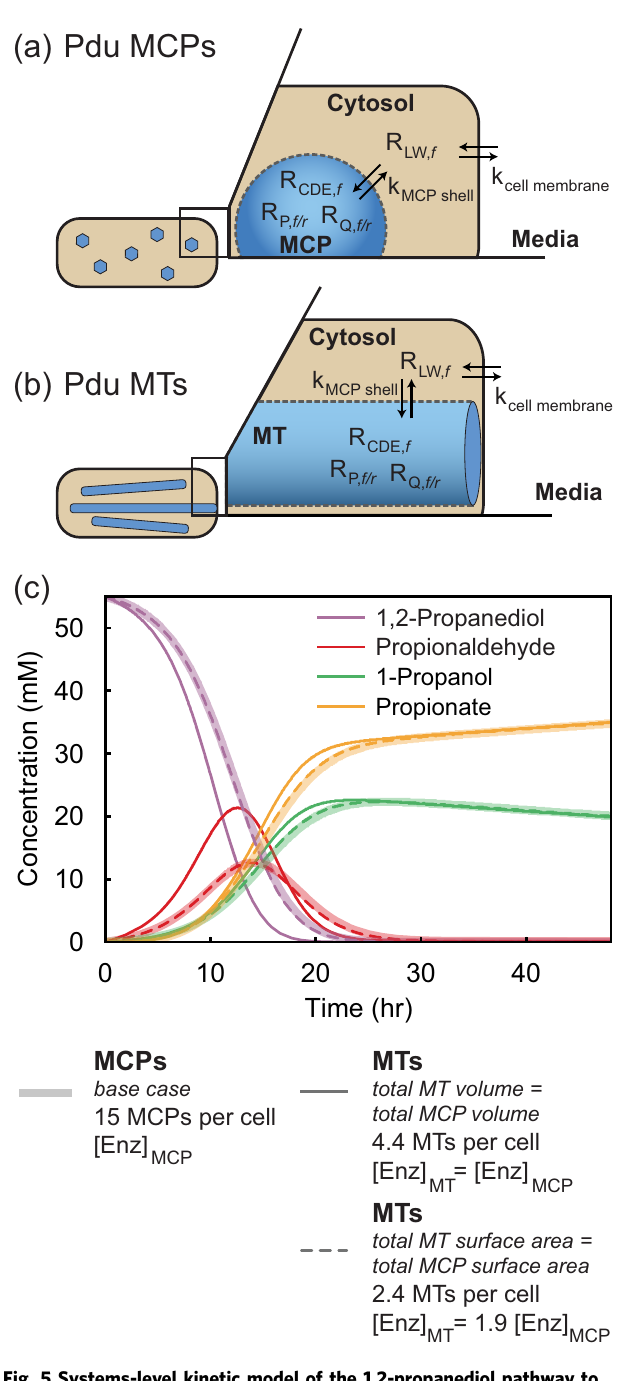
Fig. 5 Systems-level kinetic model of the 1,2-propanediol pathway to explore the impact of compartment geometry on pathway performance. a Spherical MCP model, where R refers to a reaction by a given enzyme, and k refers to diffusion across a barrier (the compartment shell or cell membrane) with a given permeability. b Cylindrical Pdu MT model. c Representative metabolite pro fi les in external media produced by the model for the spherical MCP base case (thick, slightly transparent lines), and limiting cylindrical MT cases (thinner, darker lines--solid for the case where internal MT volume is assumed the same as total MCP volume, and dashed for the case where total MT surface area is assumed to be the same as total MCP surface area). Data presented are concentration pro fi les calculated deterministically assuming an initial condition of 55 mM 1,2- propanediol in external media. Source data are provided as a Source Data fi